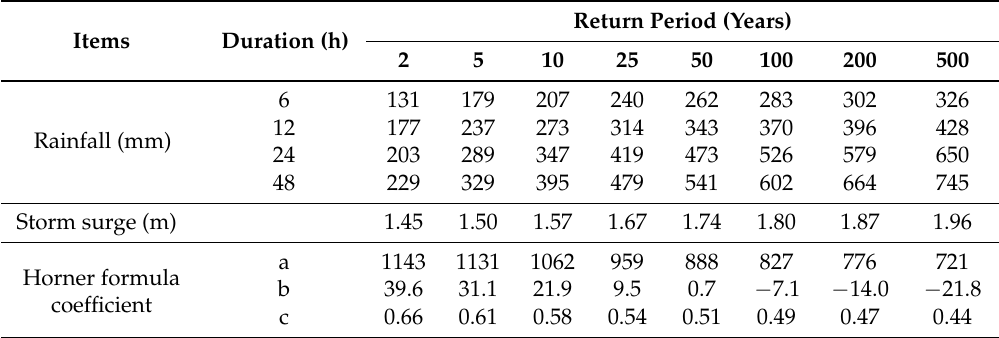
Table 4. Results of frequency analysis on rainfall and storm surge and calibration of the coefficients of Horner formula at Tainan Station (Station No.